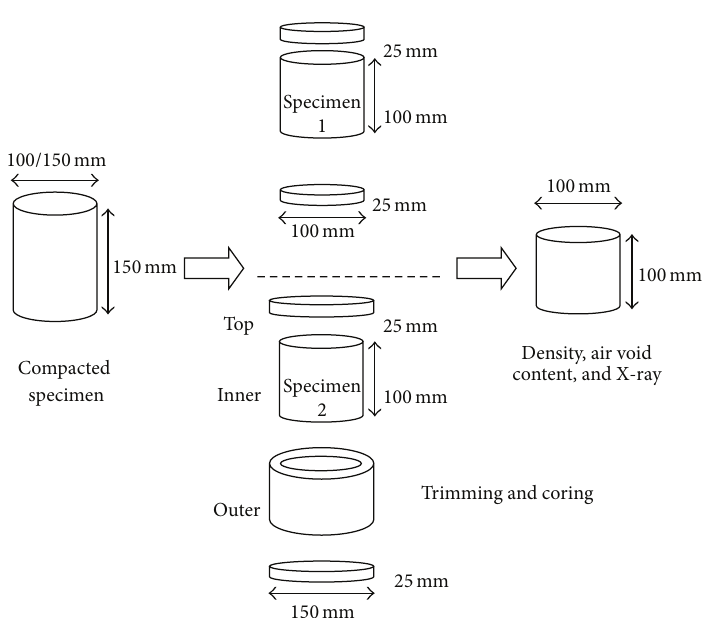
Figure 2: Trimming and coring works of (100/100) specimen from specimens 1 and 2.